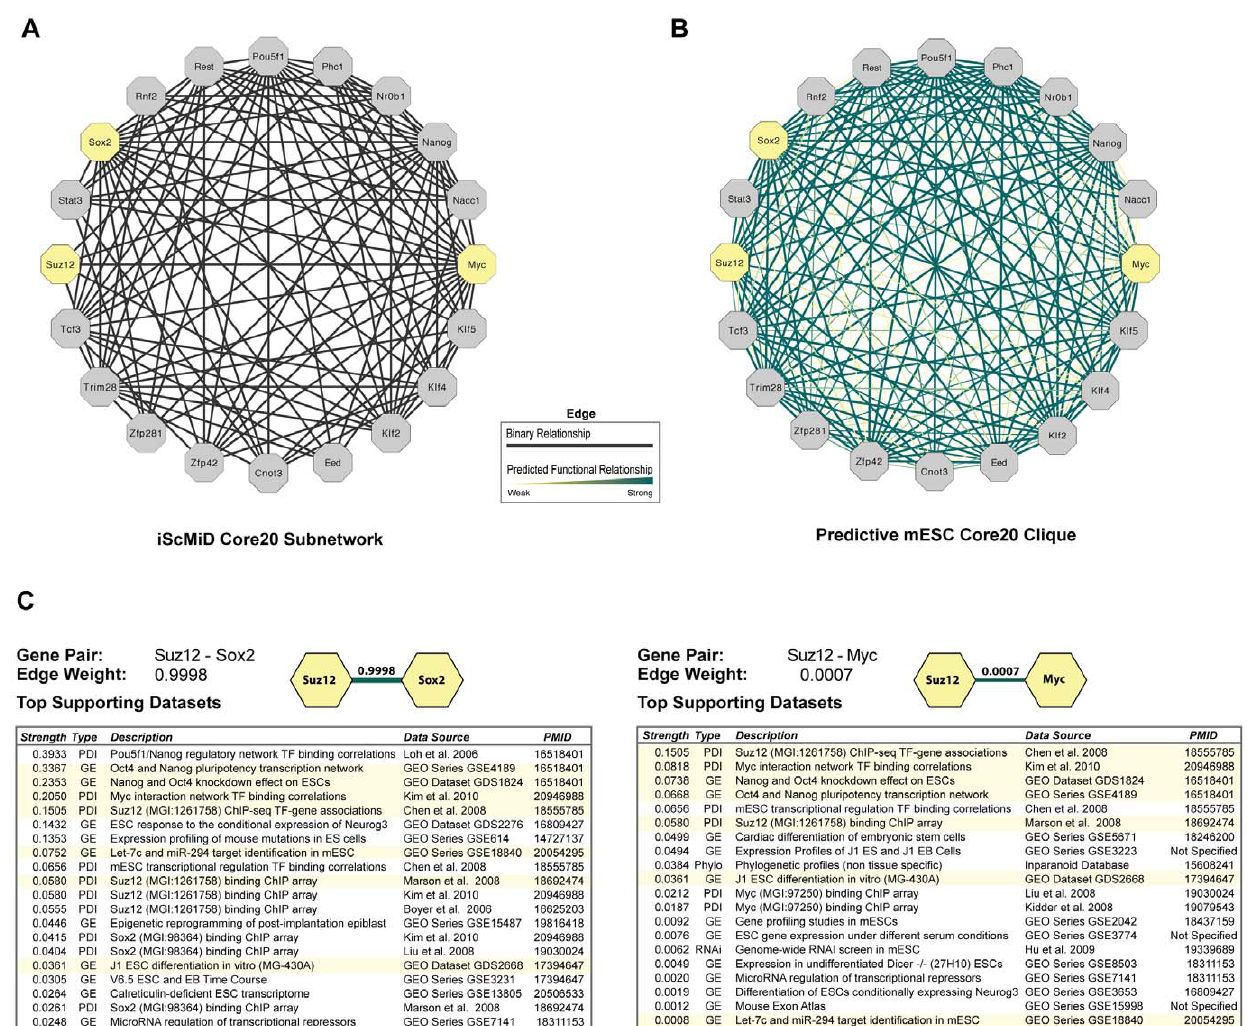
Figure 6. Advantages of Statistically Principled Approach. A. The iScMiD Core20 subnetwork of transcription factors used as bait in the 12 studies included in the iScMiD integrated mESC database [34,35], recreated as an undirected graph using edges available from the iScMiD website. In the iScMiD network, all edges have equal weight and all high-throughput data is considered equally reliable, hence the authors note there may be many false positives. B. The fully connected clique of mESC network posteriors for the iScMiD Core20 transcription factors predicts connections not shown in iScMiD and reveals potential false positives as not all connections are equally supported by the evidential data. For comparison, we checked underlying data for two edges, highlighted in yellow, one of which is not supported in the iScMiD subnetwork (Suz12– Sox2), and one which is only weakly supported in our mESC-only network (Suz12– Myc). C. Contrasting detailed information about underlying data supporting the strong functional linkage between Suz12 – Sox2 (Edge Weight: 0.9998) versus the weak linkage between Suz12 – Myc (Edge Weight: 0.0007) shows that top supporting datasets vary from edge to edge and that the strength of dataset contribution to edge weight may differ significantly. (Highlighted rows are datasets that support both